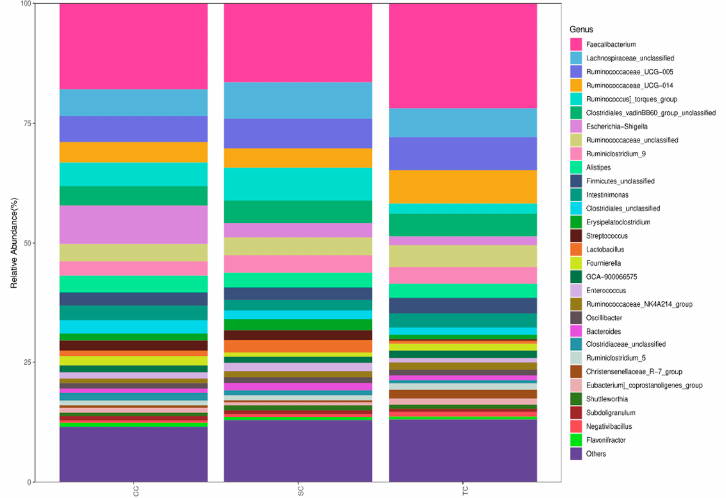
Figure 3. The relative abundance of bacterial genera in the cecal microbiota of broilers in different groups. CC, control group; SC, 25% of soybean meal (SBM) replaced with fermented SBM (FSBM); TC, 50% of soybean meal (SBM) replaced with fermented SBM (FSBM). LEfSe was applied to explore the relative richness ( p < 0.05, LDA > 3) of the cecal microbiota of broilers in the three groups. The results suggest that dietary treatment modified the microbial composition of cecal digesta. The genera Ruminococcus_torques_group , Lactobacillus , Akkermansia , Gastranaerophilales , and Lachnoclostridium were enriched in the SC group, whereas the microbiota of the CC group was enriched with the genera Clostridiales and Anaeroplasma (Figure 4).